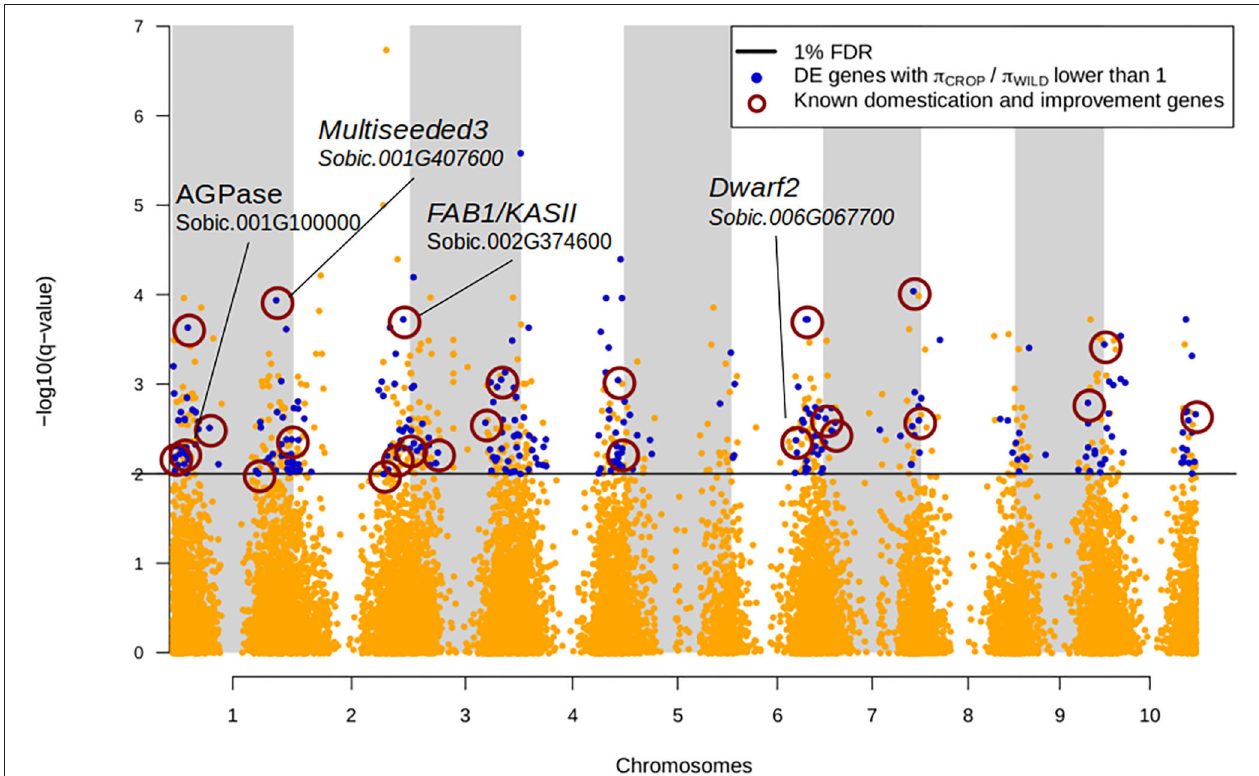
FIGURE 2 | Manhattan plot of FDR q -values associated with the differential expression analysis between wild and domesticated sorgho. Genes were declared significantly differentially expressed at 1% FDR (black line). Genes with lower nucleotide diversity in the domesticated pool ( π CROP / π WILD ) are represented in blue. Among them, 70 are known candidate domestication/improvement genes (dark red circles, Supplementary Table 3 and ref. therein). The position of four genes affecting the domesticated phenotype is also represented.